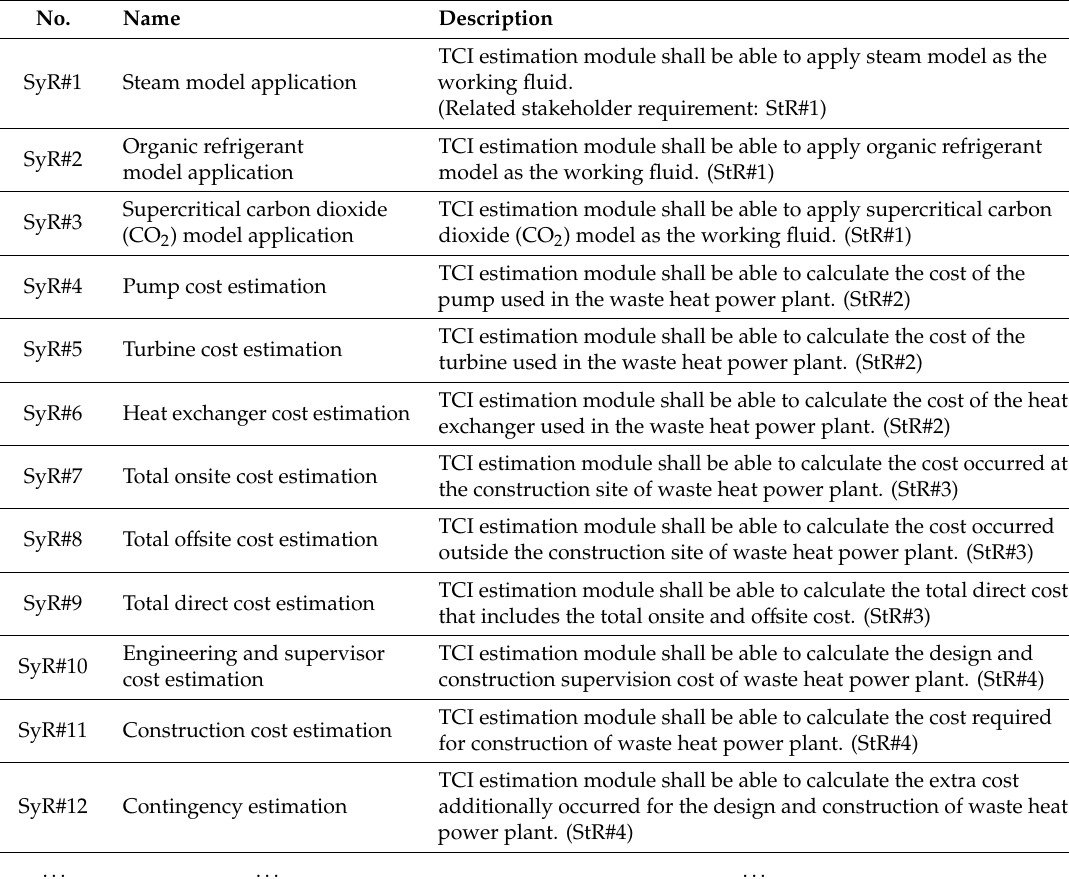
Table 5. System requirements of the TCI estimation